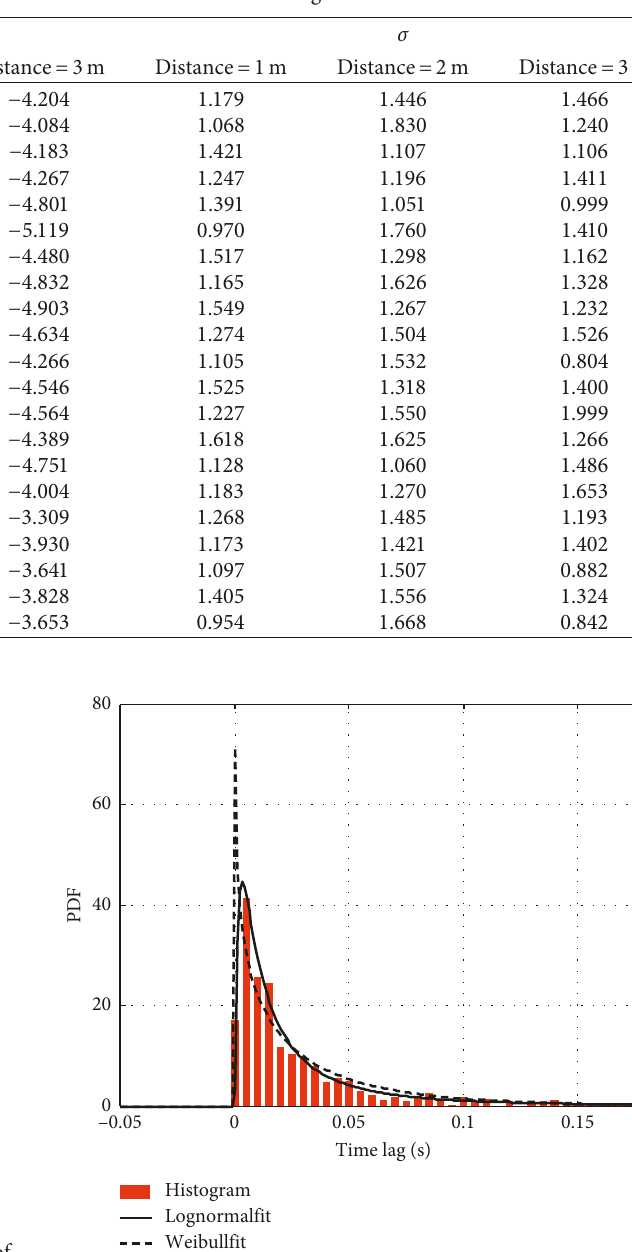
Figure 24: Distribution results of coherence coefficients between each two participants at 1.8Hz for the reference